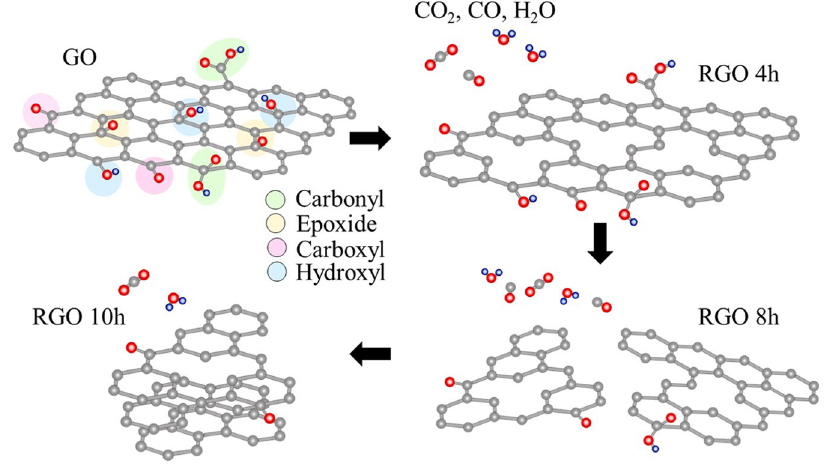
Figure 5. Schematic illustration of GO reduction with time dependence.